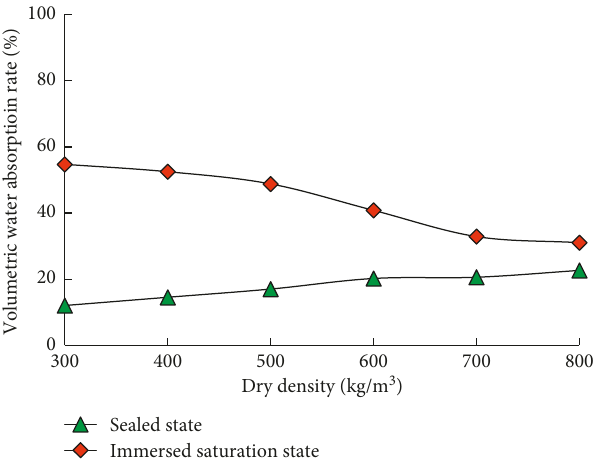
Figure 9: Relationship between dry density and volumetric moisture content at different water